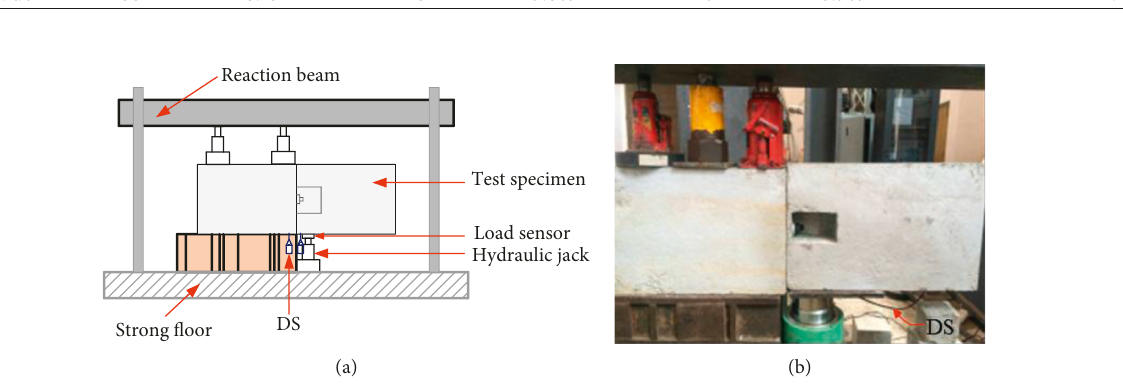
Figure 8: The shear test setup.